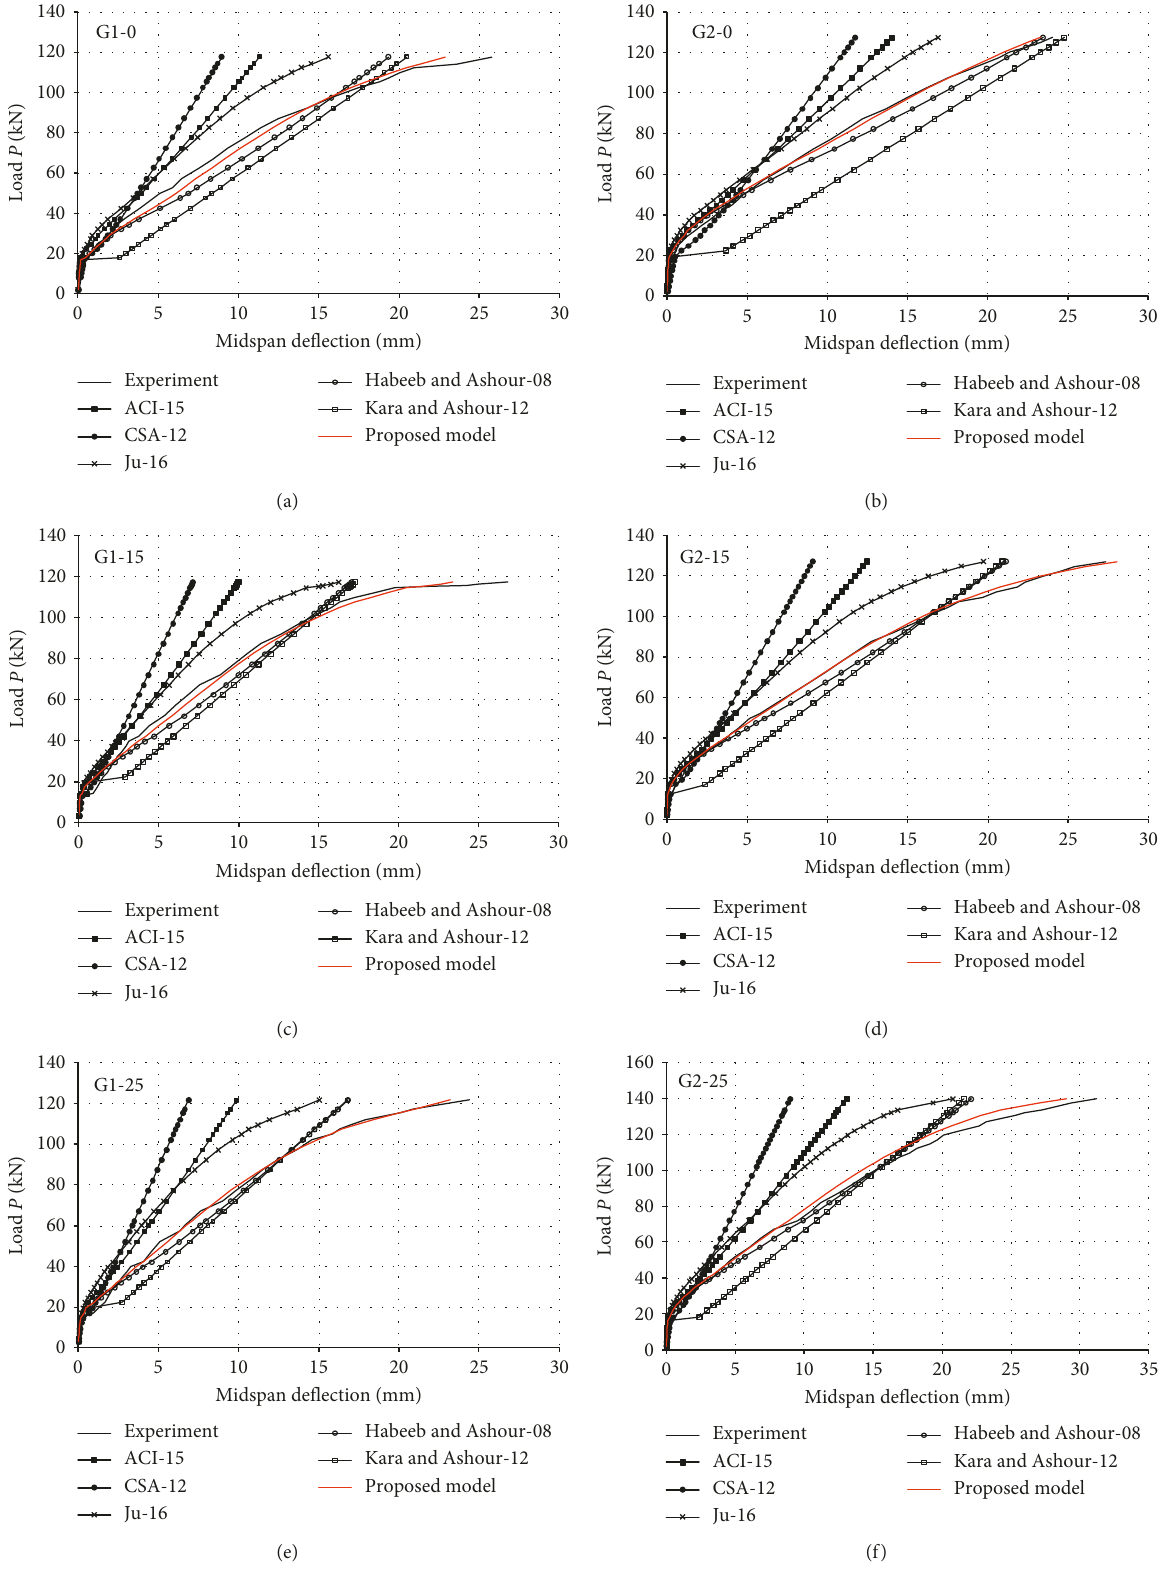
Figure 13: Experimental and predicted deflection for tested beams. (a) G1-0. (b) G2-0. (c) G1-15. (d) G2-15. (e) G1-25. (f)